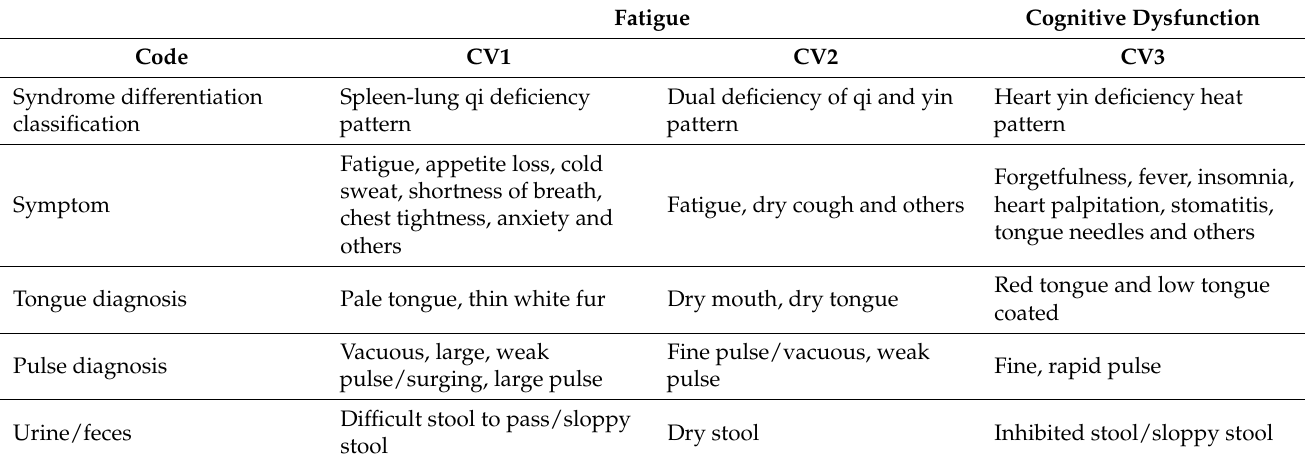
Table 2. KM syndrome differentiation for allocation to treatment